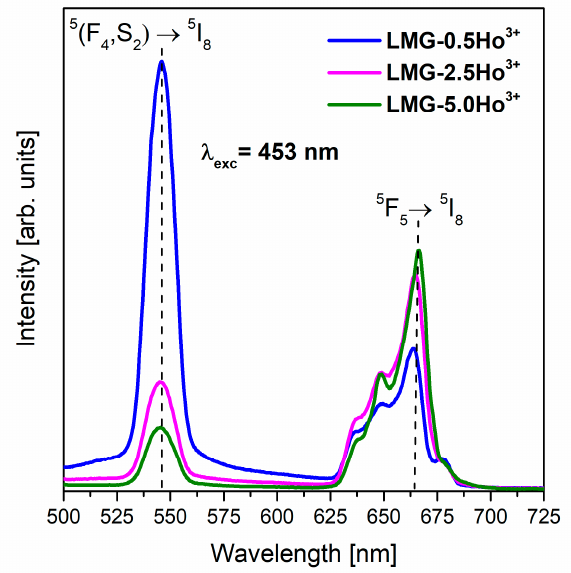
Figure 4. Luminescence spectra for LMG-Ho 3+ ceramics with different contents of holmium ions.